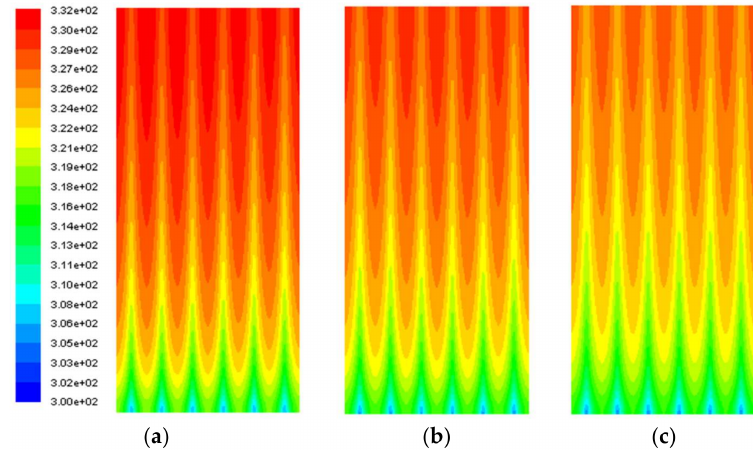
Figure 17. Temperature contours in absorption plate for ( a ) Case 0, ( b ) Case 4, ( c ) Uniform flow